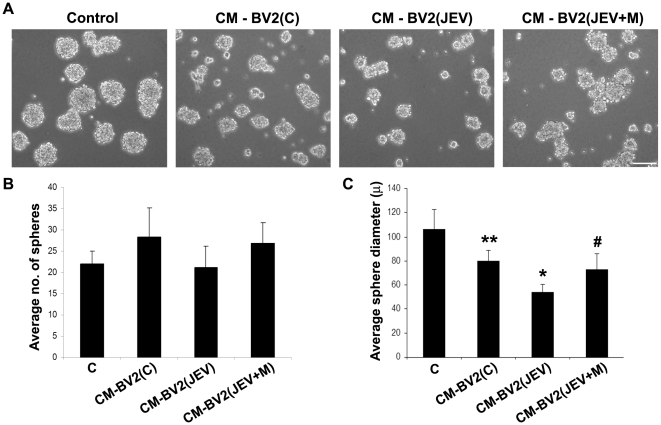
Impaired neurosphere formation by soluble mediators from JEV activated microglia is reversed by minocycline treatment.Single cell suspensions of NSPCs were cultured alone (C) or in presence of BV2-derived CM under 3 conditions- BV2(C), BV2(JEV), BV2(JEV+M) for 3 days. Phase-contrast micrographs of neurospheres were acquired under 10× magnification (A). Scale bar is 100 µ. The number of neurospheres was counted from 10 different fields for each condition and the average diameter of the spheres was measured using Leica IM50 software. The graphs represent the average number of spheres (B) and their average diameter in microns (C). The numbers of colony forming neurospheres do not show any significant difference between groups (B). The reduction in size of neurospheres grown in CM from BV2(JEV) was prominent compared to CM-BV2(C) or CM-BV2(JEV+M) conditions (C). Values represent mean ± SEM from 3 independent experiments performed in duplicate (** significant change from control, p<0.05; * significant change from CM-BV2(C), p<0.01; # significant change from CM-BV2(JEV), p<0.01).